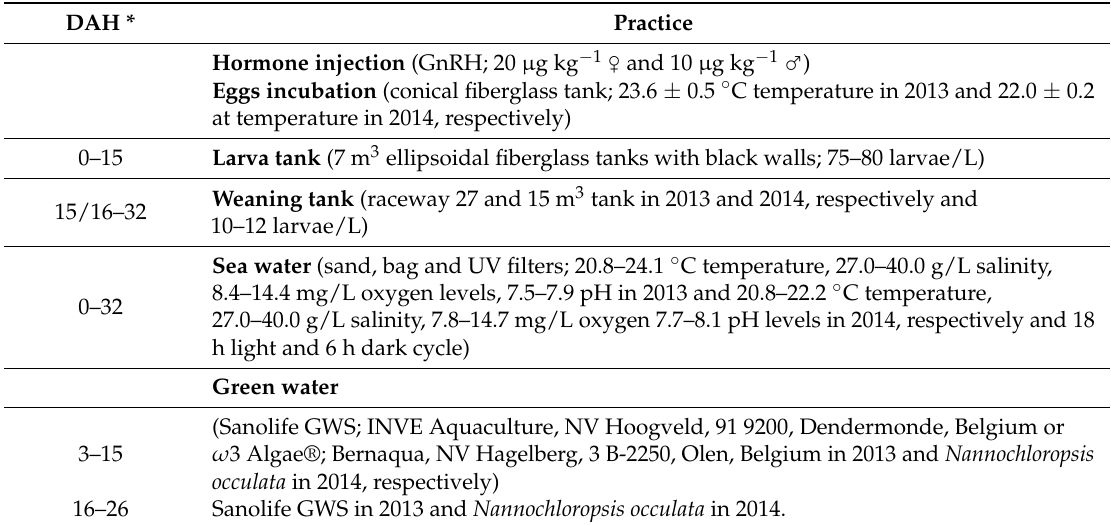
Table 3. Meagre larvae’s rearing